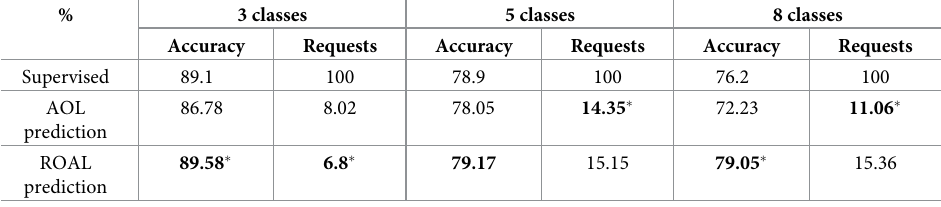
(Results with statistical significance at the 0.05 level with respect to the Student’s paired t -test are marked with �